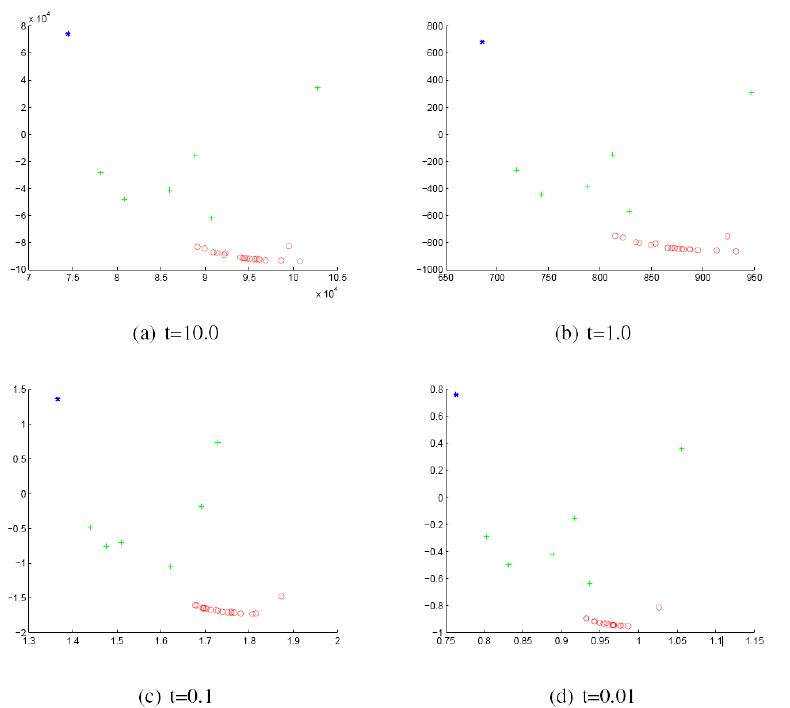
Figure 3. MDS embedding obtained using HD for the houses data represented by the Gaussian curvature associated with the geodesic triangles. The x and y axes are the embedding coordinates corresponding to the leading two dimensions of the MDS embedding. The differently-coloured symbols denote different object classes.